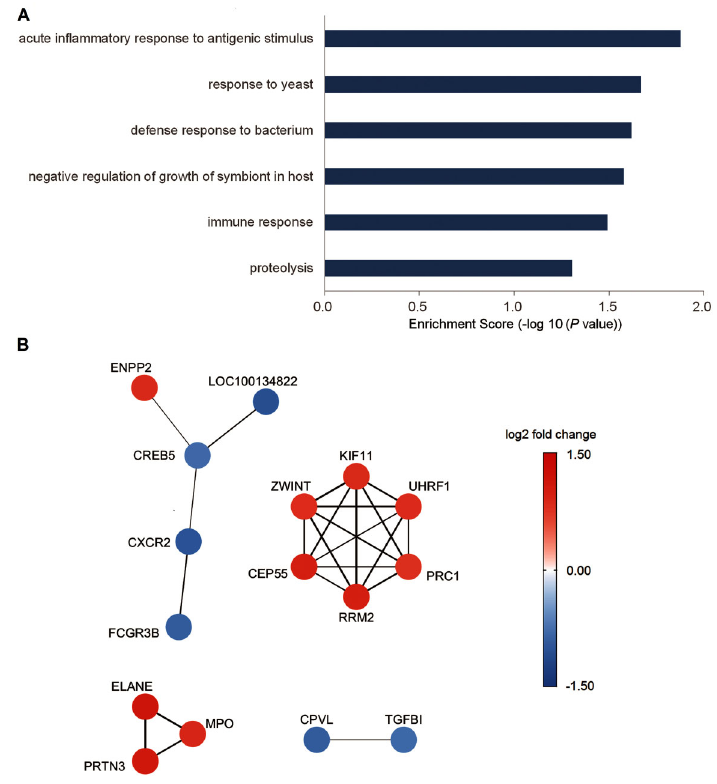
Figure 2. Enrichment analysis and co-expression network construction results. A , Summary of the gene ontology analysis results for the differentially expressed (DE) genes in pediatric septic shock non-survivors. B , Co-expression network of highly correlated DE gene pairs in pediatric septic shock non-survivors (correlation coef fi cients 4 0.8). Edge widths are proportional to the correlation coef fi